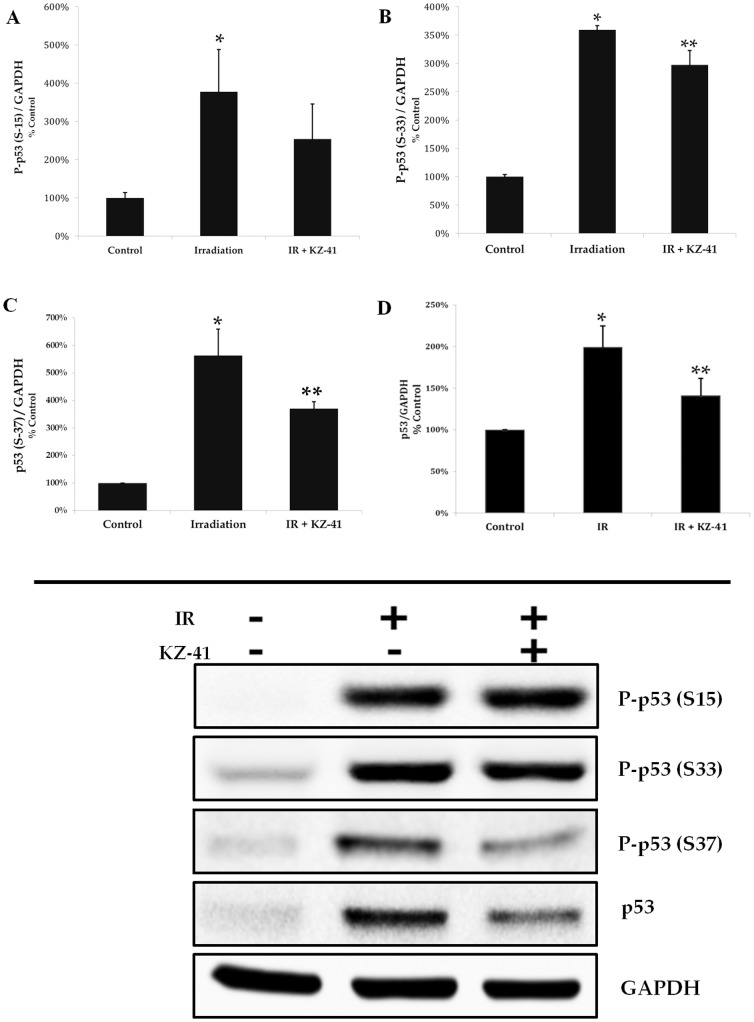
Radiation-induced p53 phosphorylation and accumulation.A–C) Phosphorylation at serine 15, 33, 37 was significantly induced by irradiation (*P<0.05) after 4 hours. The ratio of p53 phosphorylation at Ser 33 and 37 (relative to GAPDH) in KZ-41-treated (10 µM) RECs showed significant reduction (**P<0.05). D) Total p53 protein accumulation revealed significantly reduced levels in KZ-41 treated RECs (**P<0.05).